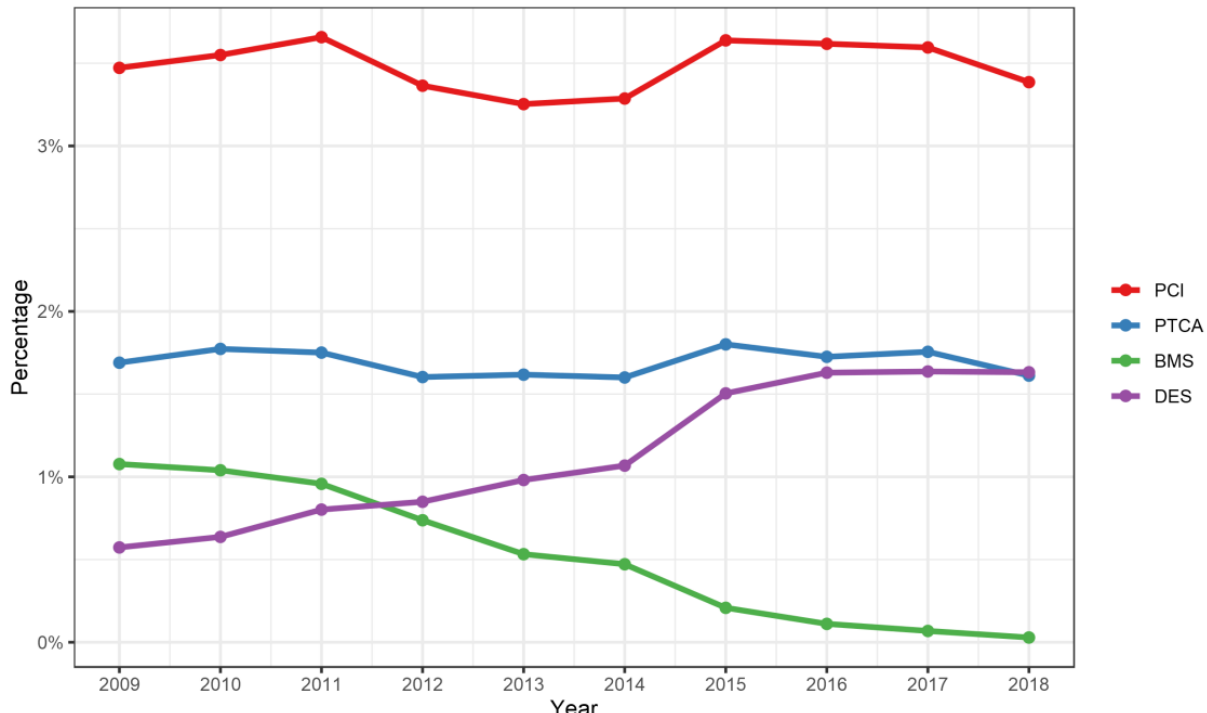
Figure 4. Prevalence of coronary interventions in patients hospitalized due to PAD between 2009 and 2018 in (%). PCI: percutaneous coronary intervention; PTCA: percutaneous transluminal coronary angioplasty; BMS: bare-metal stent; DES: drug-eluting stent.